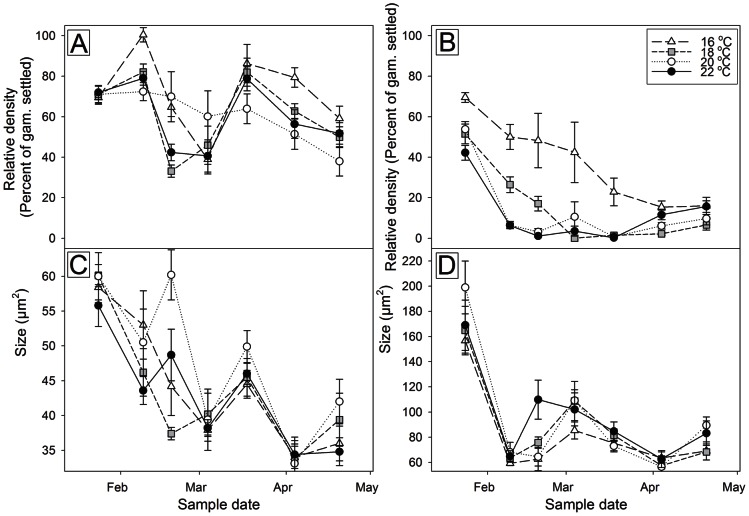
The mean (±SE) relative density and size of gametophytes.Plots represent relative density measured after 3 (A) and 6 (B) days of culture, and the mean (± SE) size of gametophytes measured after 3 (C) and 6 (D) days of culture. Gametophytes were grown in four different temperatures; 16°C (white triangle, long dash line), 18°C (grey square, small dash line), 20°C (white circle, dotted line), 22°C (black circle, solid line).